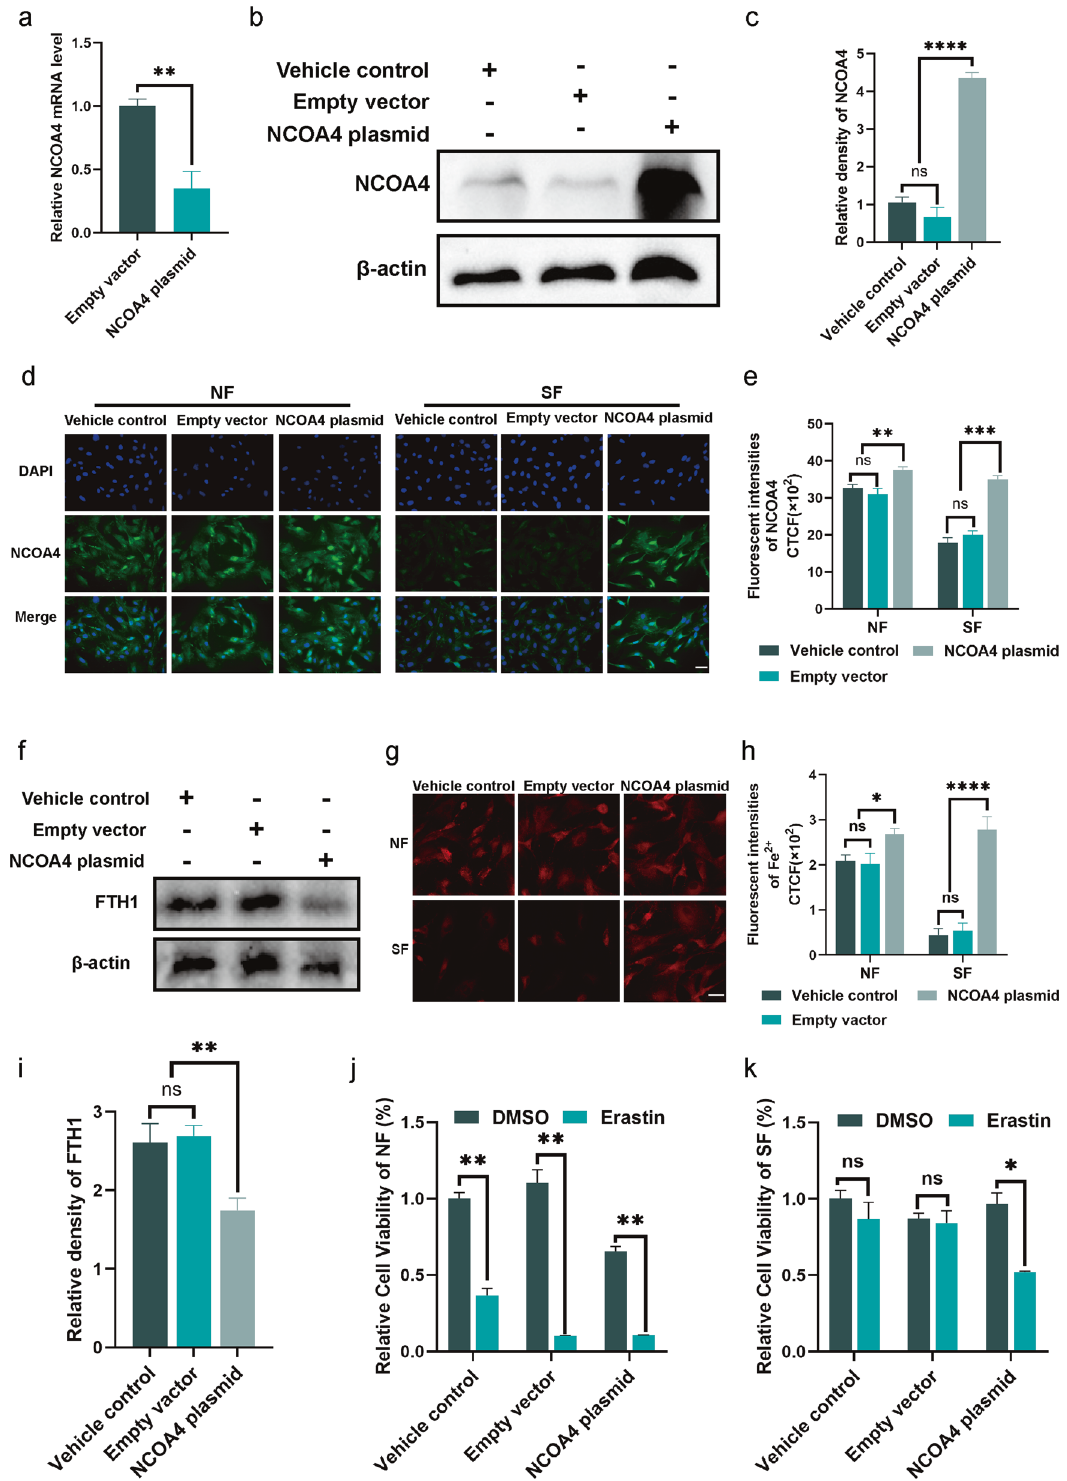
Fig. 4 Overexpression of NCOA4 repaired the ferritinophagy in senescent fi broblast. a , b The mRNA and protein level of NCOA4 in fi broblasts to detect the transfection ef fi ciency of NCOA4. c Quanti fi cation of NCOA4 immunoblotting in b . d Immuno fl uorescence staining of NCOA4 in NF and SF after transfected NCOA4 plasmid. Scale bar = 100 μ m. e Quanti fi cation of NCOA4 immuno fl uorescence staining in d . f Immunoblot of FTH1 in SF with the indicated treatment. i Quanti fi cation of FTH1 immunoblotting in f . g Intracellular free iron ions in fi broblasts with the indicated treatment. Scale bar = 50 μ m. h Quanti fi cation of intracellular free iron ions in g . j , k Relative cell viability of NF and SF with erastin (5 μΜ ) stimulation after transfection. Data represent the mean ± SEM of triplicates. ** P < 0.01; **** P < 0.0001. DW diabetes wounds, NS normal skin, NF normal fi broblast, SF senescent fi broblast, CTCF corrected total cell fl uorescence.